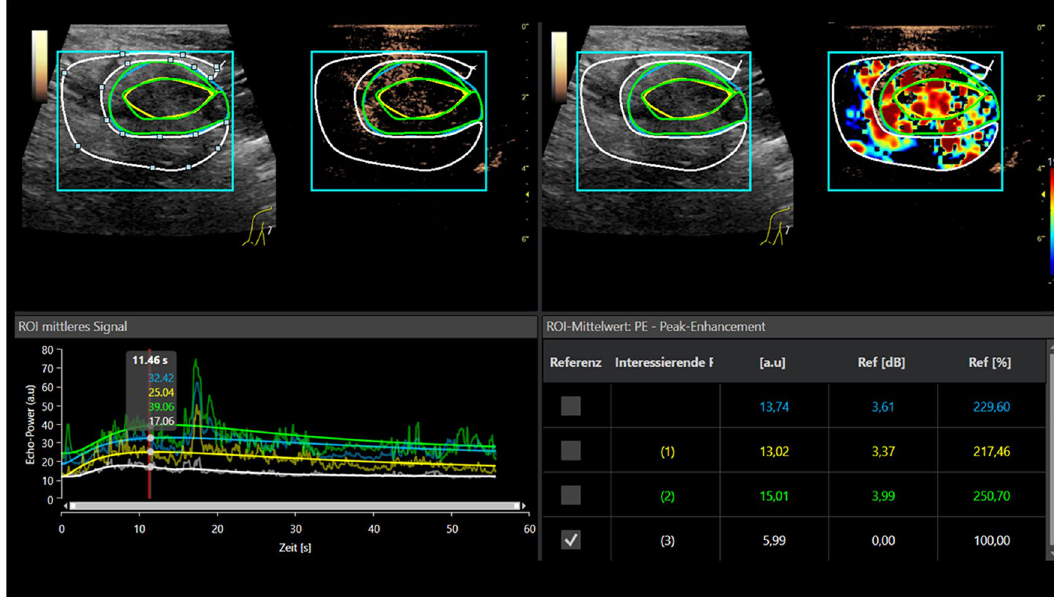
Figure 2. CEUS Perfusion evaluation of a small benign breast tumor, histo-pathologically proven fibroadenoma. Contrast enhanced perfusion evaluation up to 60 s for measurement of the PE. In parametric imaging irregular red and yellow shades for tumor micro-vascularization. There is hardly any difference visible when compared to the surrounding tissue (also in yellow shades). Slower wash in rate, lower peak and prolonged wash out in time intensity curve analysis (TIC) as criteria for a benign breast tumor.